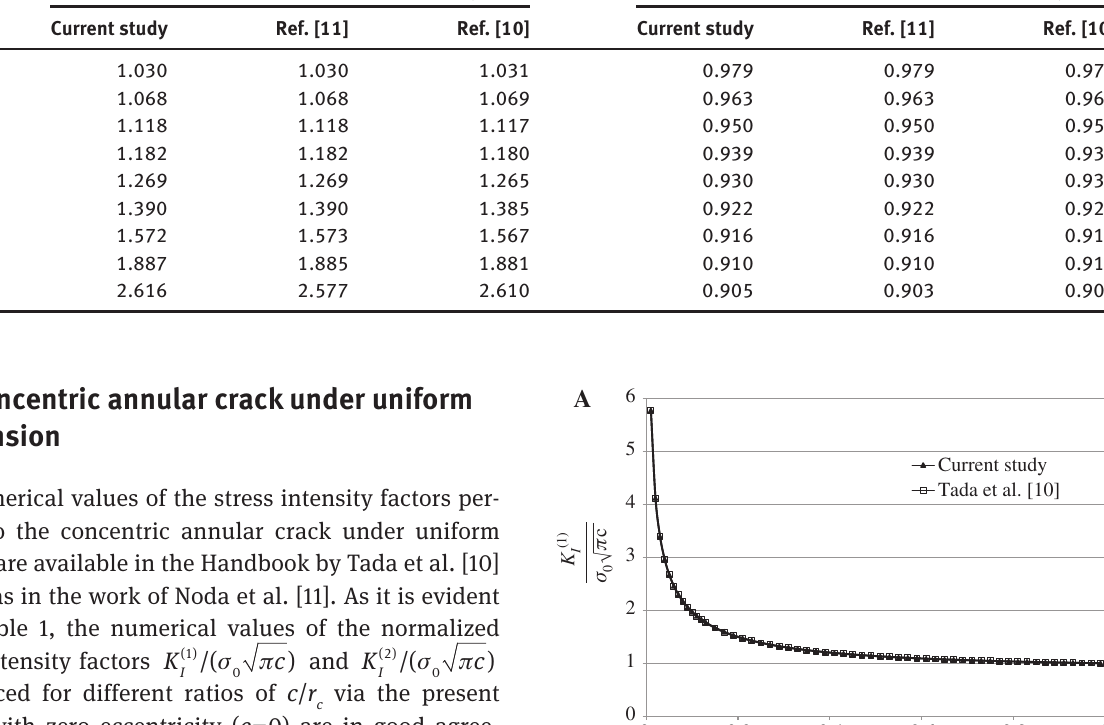
Table 1: Comparison of the values of the inner and outer stress intensity factors for various ratios of c / r crack with those of Noda et al. [11] and Tada et al. [10]. c / r c